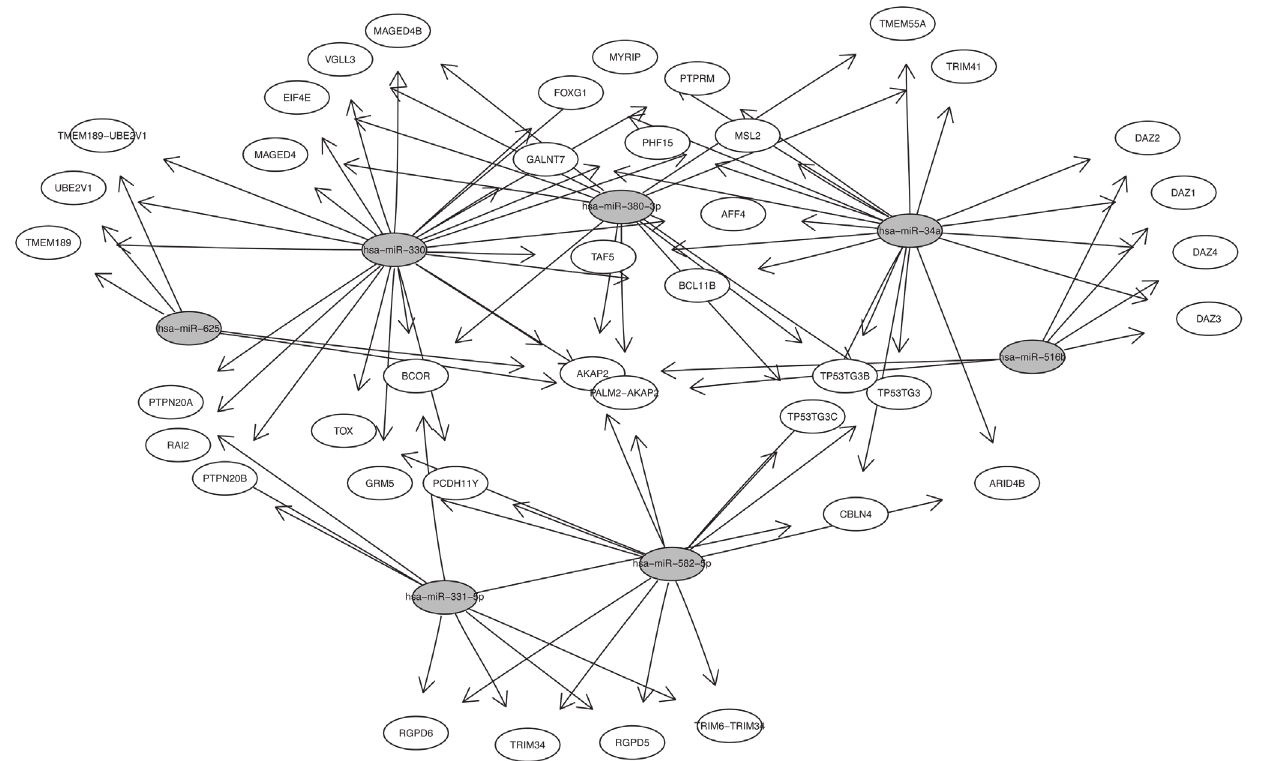
Figure 5. Predicted common targets of miRNAs expressed exclusively in FSHD1. Five different algorithms were used to identify the predicted targets for miRs exclusively expressed in FSHD1 biopsies, and only the target-genes predicted in at least 3 of them were considered as probable target. In gray, miRNAs exclusively expressed in FSHD1 fetal muscle biopsies and in white, target genes of these FSHD1